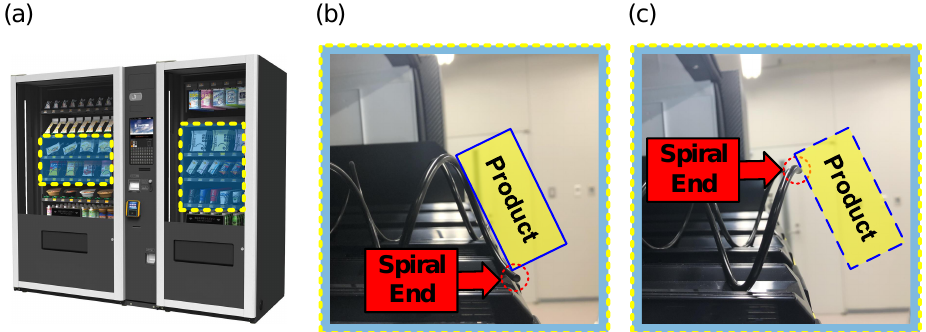
Figure 1. ( a ) An overall view of a multi-purpose vending machine in which most racks are spirals. The mechanism of dispensing products by the spiral rack with ( b ) a potential failure case; and ( c ) a successful